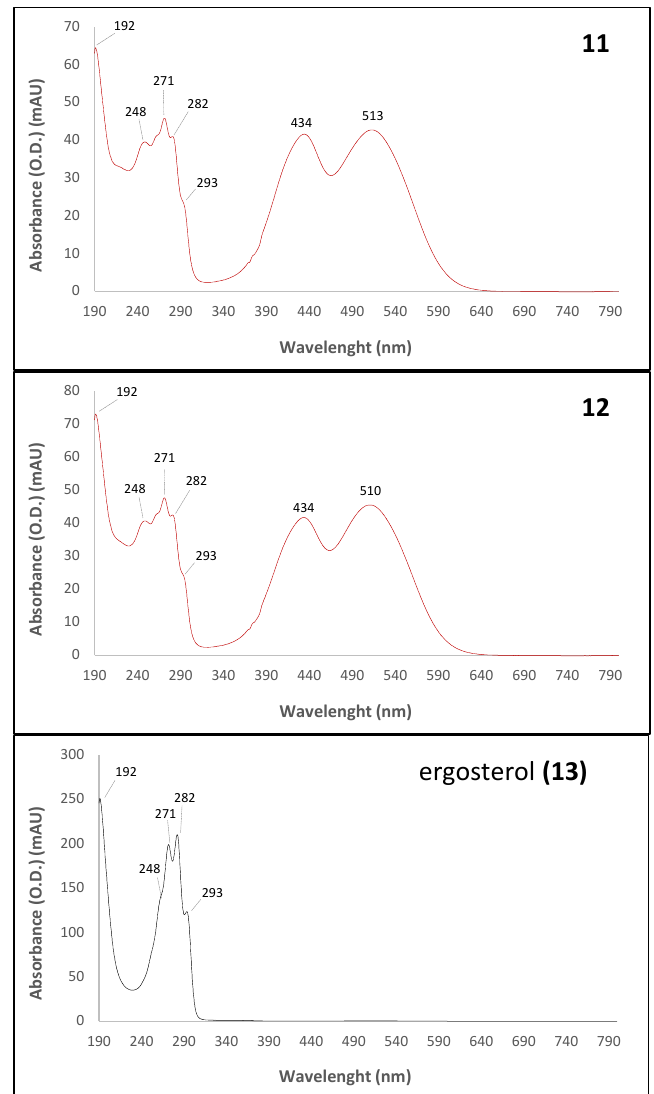
Figure 6. UV-visible spectra of the ergosterol (colorless compound 13 ) and the two pigmented ergosterol derivatives of azaphilone compounds 11 and 12 with reference to the chromatograms shown in Figure 3, detected in the present study in intracellular extracts of the marine isolate Talaromyces sp.